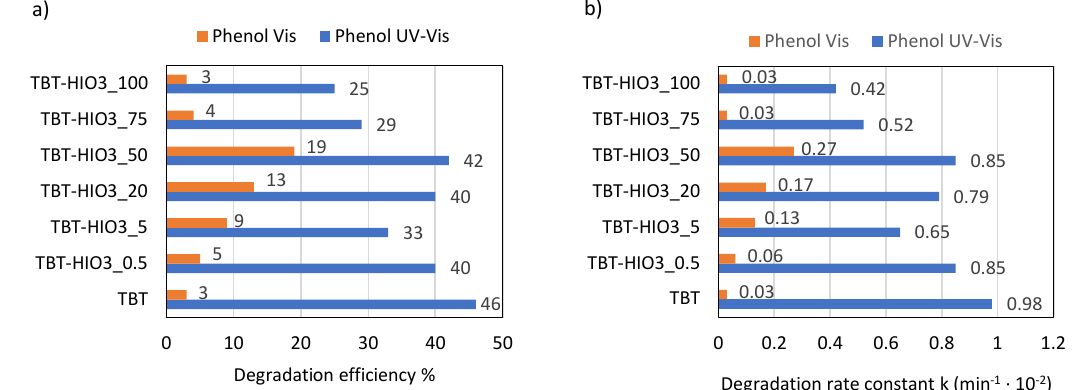
Figure 13. Efficiency of phenol degradation in UV-Vis and Vis light for defective TiO 2 -HIO 3 photocatalysts, presented as % of degradation ( a ) and rate constant k ( b ).